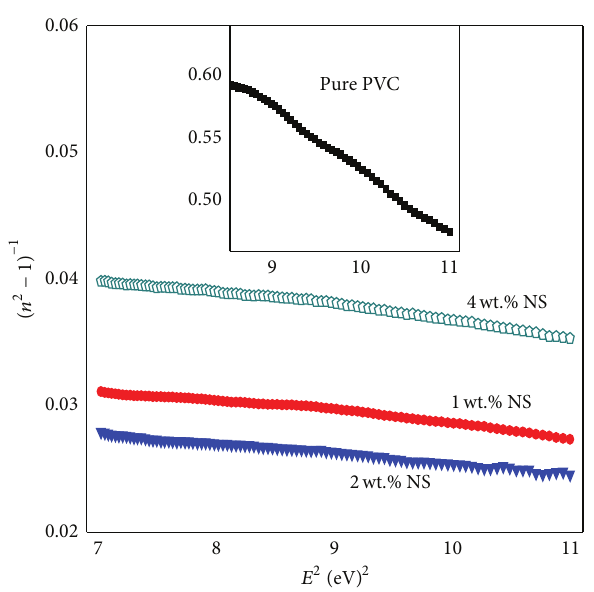
Figure8:Plotsof (𝑛 2 −1) −1 against (𝐸) 2 forpurePVCandPVC-SiO 2 nanocomposite